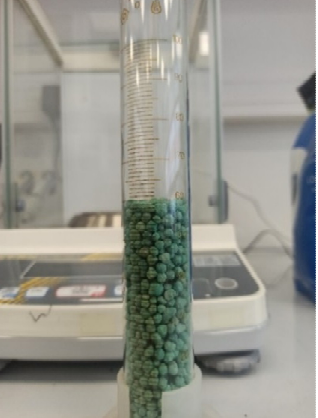
Figure 3. Measuring glass for volume measurement.